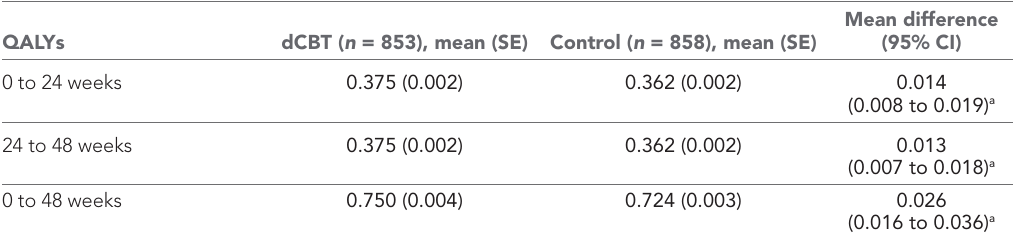
Table 3 Quality- adjusted life years from baseline to 48 weeks